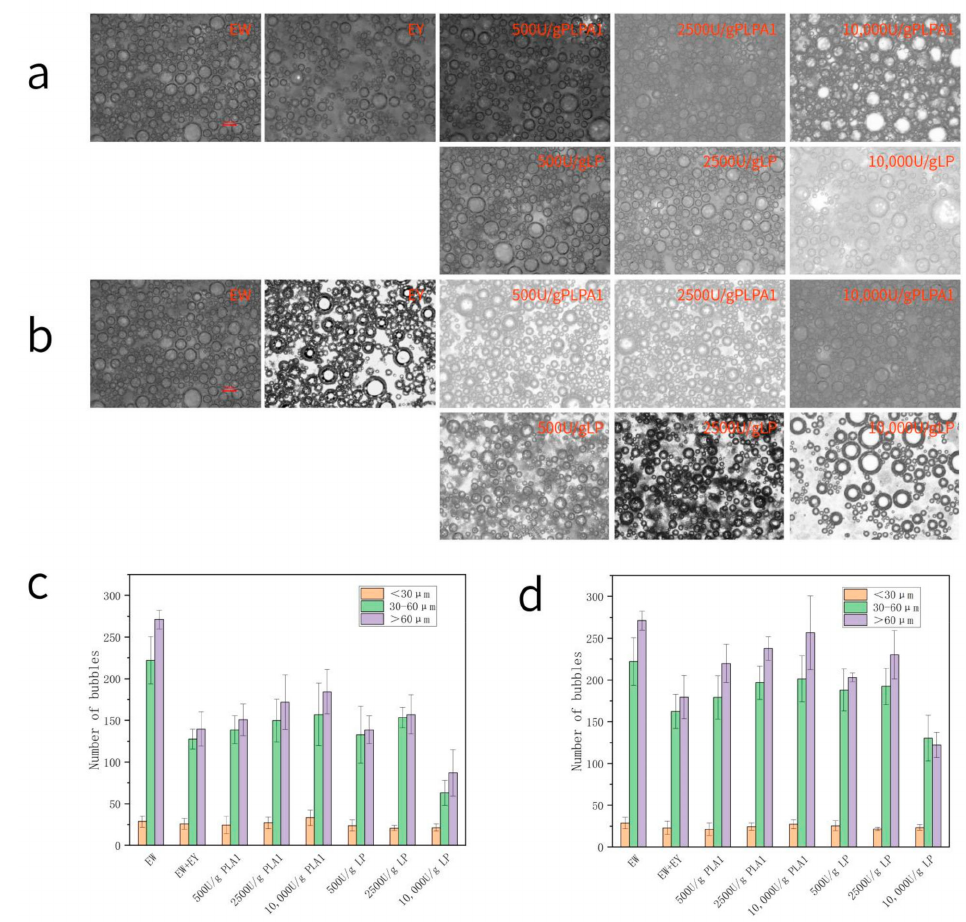
Figure 5. Microstructures of fresh batters. Samples prepared by 0.5 wt% yolk-contaminated EW dispersions ( a ) and 1 wt% yolk-contaminated EW dispersions. ( b ) Number of babbles in different diameter ranges in batter samples mixed with 1% ( c ) and 0.5% ( d ) egg yolk.